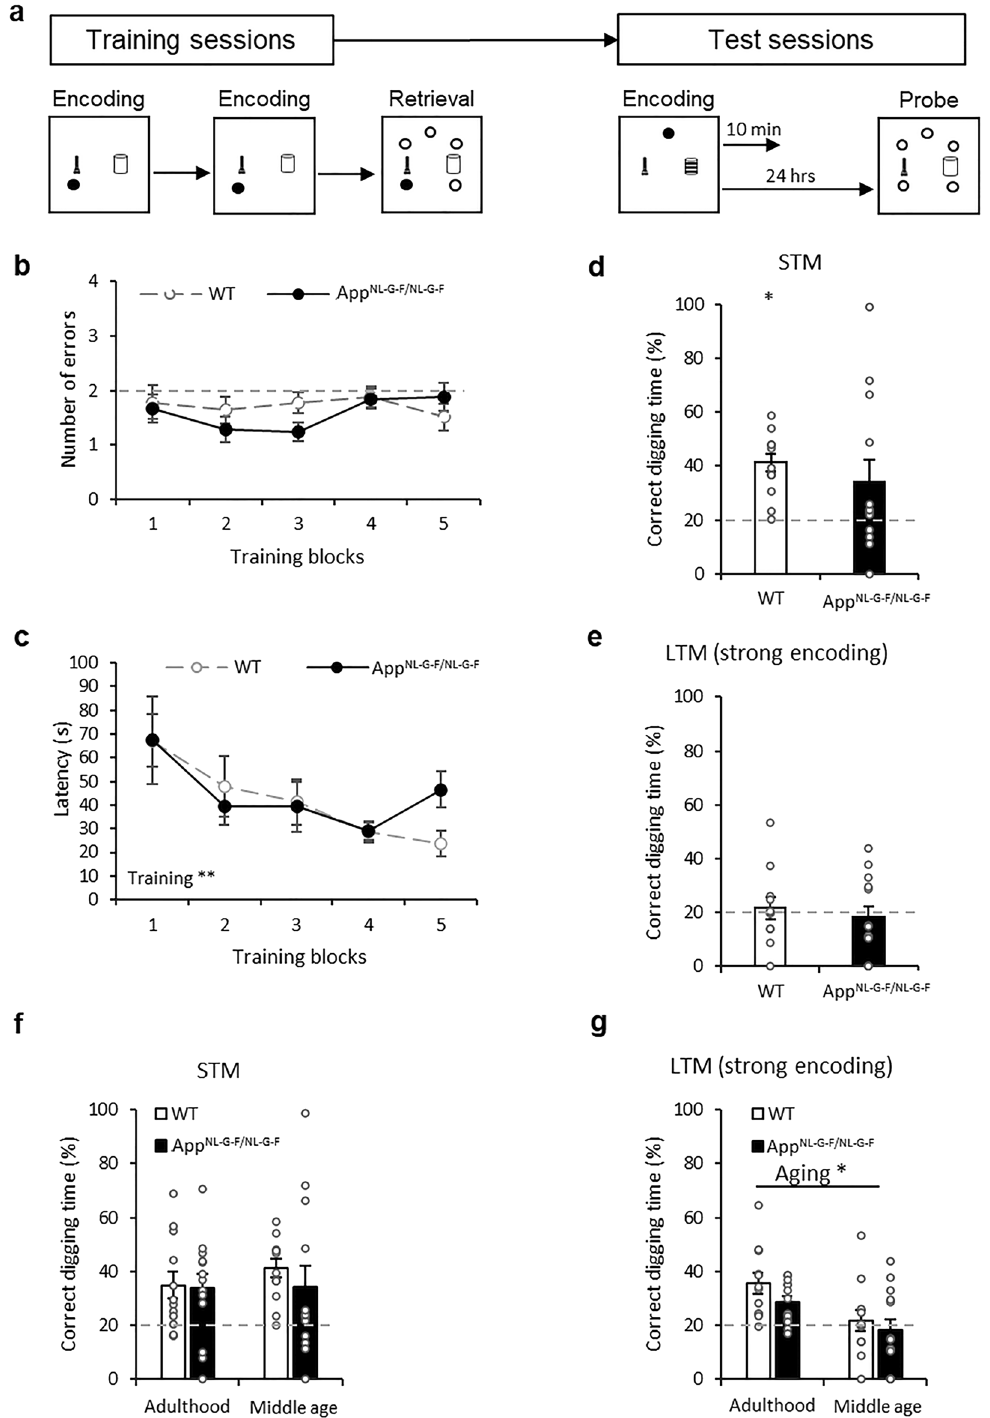
Figure 2. Appetitive spatial learning and memory in middle age. ( a ) The ADMP training and testing procedures. ( b ) Errors during 5 blocks of training were not significantly below chance. ( c ) Latencies were significantly reduced over the 5 training blocks ( d ) STM was comparable between groups. ( e ) LTM was comparable between groups but not significantly above chance. ( f ) No age-dependent decline in STM. ( g ) Age- dependent decline in LTM. Data are presented as mean ± SEM. *p <